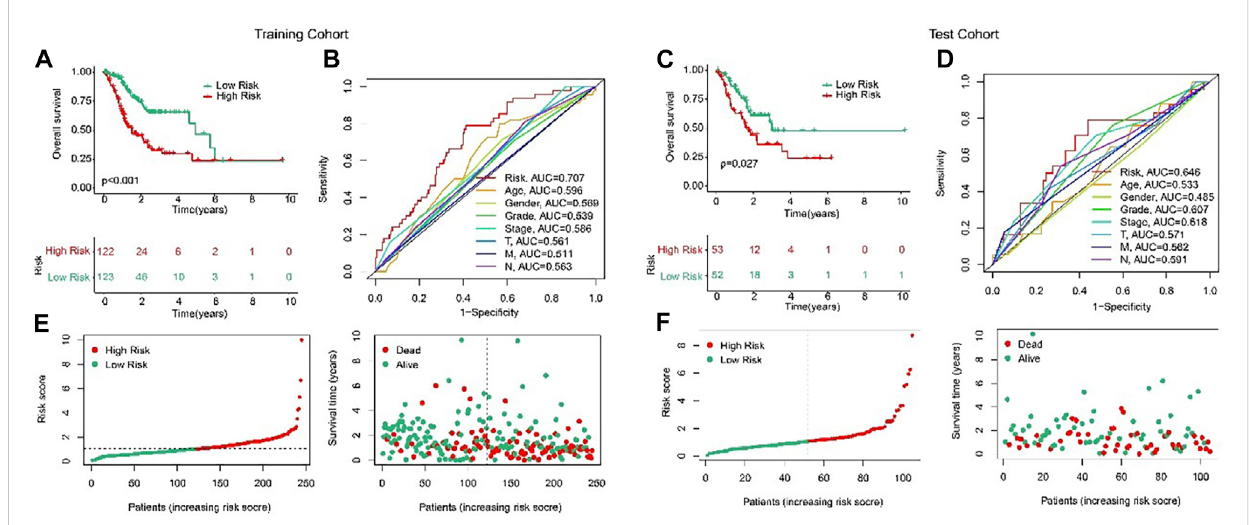
FIGURE 3 Validation of ARLs prognostic signature in STAD. Risk model construction based on the ARLs prognostic signature in training cohort (E) and test cohort (F) . The Kaplan-Meier survival curve analysis of the STAD patients with low- and high-risk score in the training cohort (A) and testcohort (C) . ROC curve shows the AUC of ARLs prognostic signature and other clinicopathological characteristics in the training cohort (B) and test cohort (D)